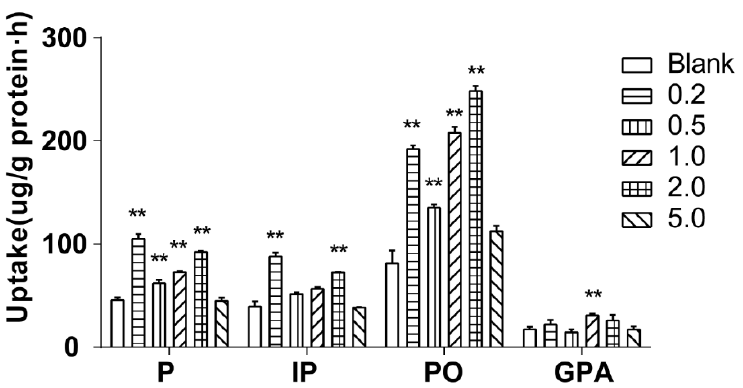
Figure 7. Cellular uptake of the 4 component compounds at different salt concentrations. Significance: vs. blank medium: ** p < 0.01.